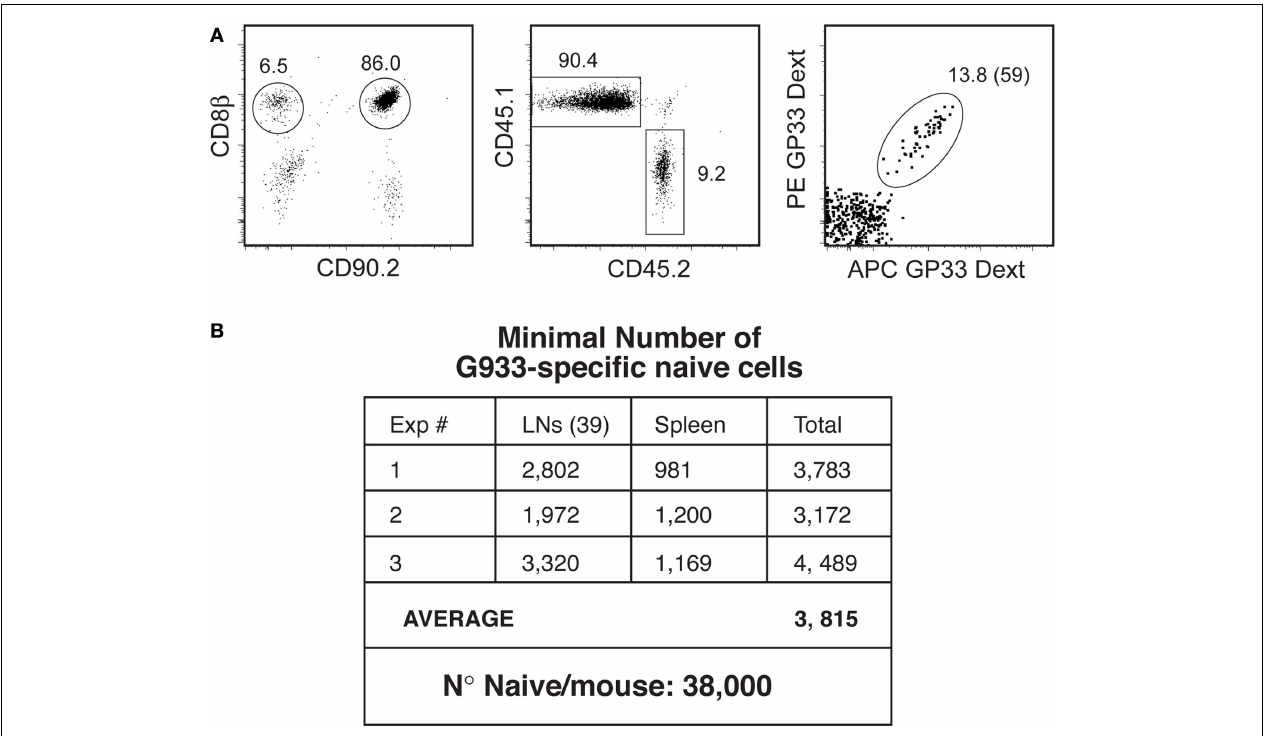
FIGURE 4 | Quantification of the naïveT cell pool . (A) Quantification of antigen-specific naïve cells in the BRLN. Reference populations (RPs: 10 4 CD90.2 CD45.1 cells and 10 3 CD90.2 CD45.2 P14 cells) were added to collagenase/DNase digests of the BRLN from CD90.1 B6 mice. Cell suspensions were depleted of non-CD8T cells, and antigen-specific-cells